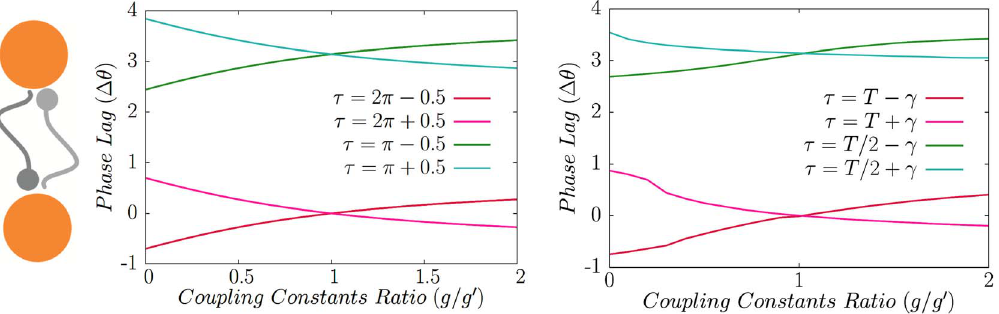
Fig. 4. Phase locked state of two directly coupled neurons in presence of inhomogeneity in the coupling strengths. The results are shown for two different values of t in which homogeneous network shows different properties (inphase and antiphase) in the homogenous case. The right panel show the similar result for HH neurons. Here T stands for oscillation period of HH neurons and c ~ 0 : 1 T